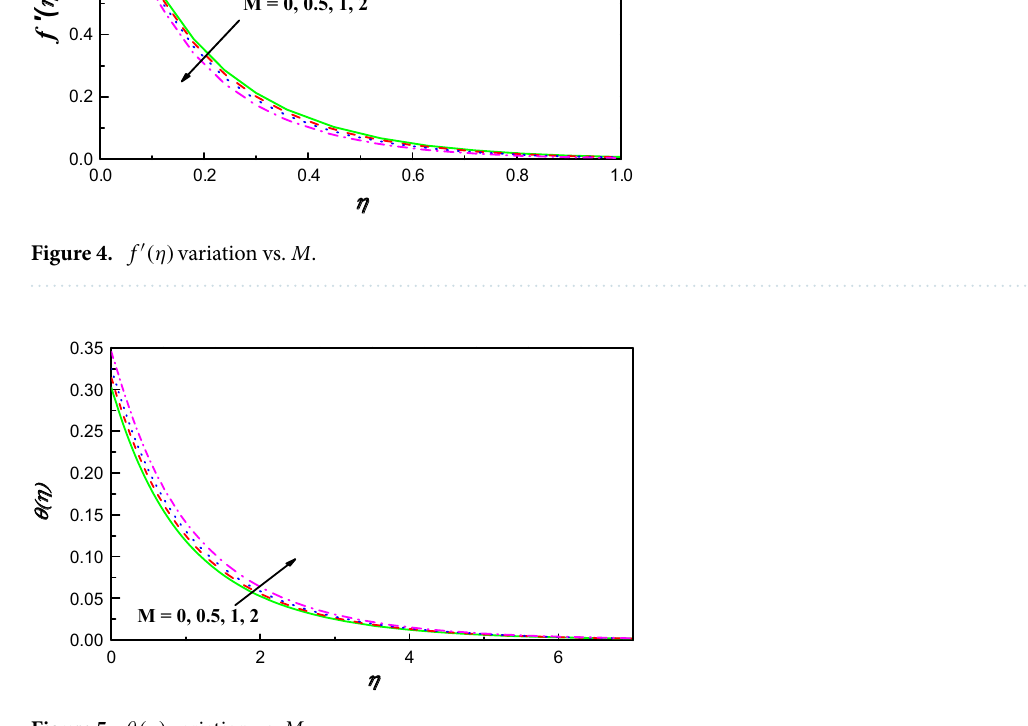
Figure 5. θ(η) variation vs. M